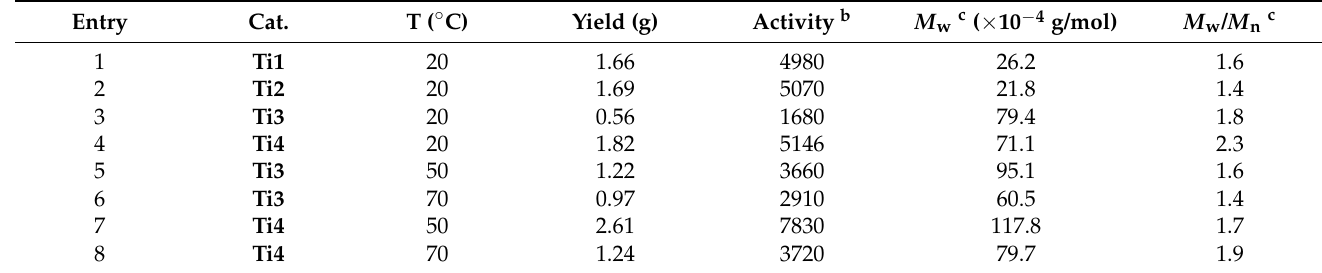
Table 1. Ethylene polymerization with Ti1 – Ti4 /DMAO catalytic systems a .